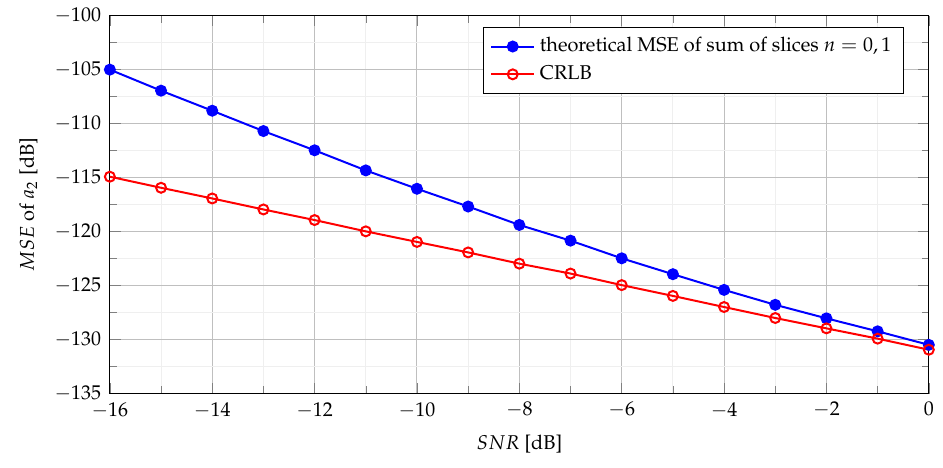
0,1 0,1 . Figure 2. Theoretical MSE of sum of slices n = { } { }